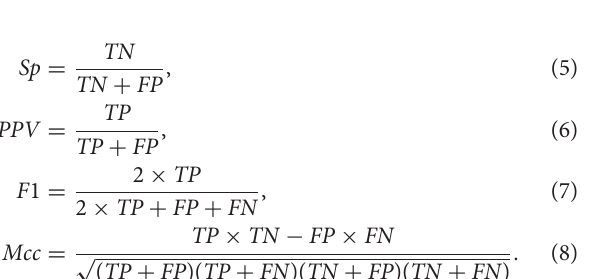
FIGURE 3 | Illustration of the LRP procedure. Relevance from each neuron propagates to neurons in a lower layer.